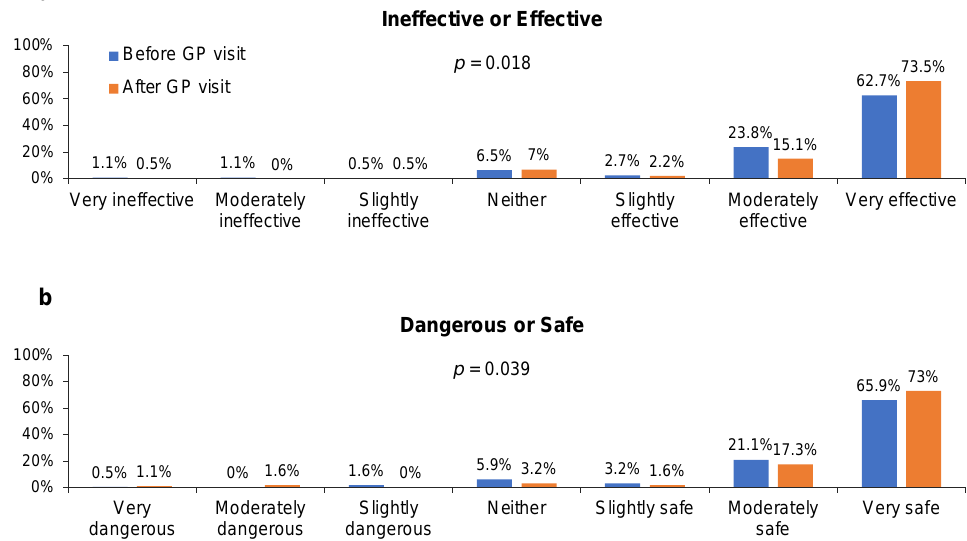
Figure 5. Responses from patients (n = 185) to the statement “Getting a flu vaccine would be ( a ) [ineffective or effective] or ( b ) [dangerous or safe]” (see specific responses along x -axes) before and after a routine visit with their GP.